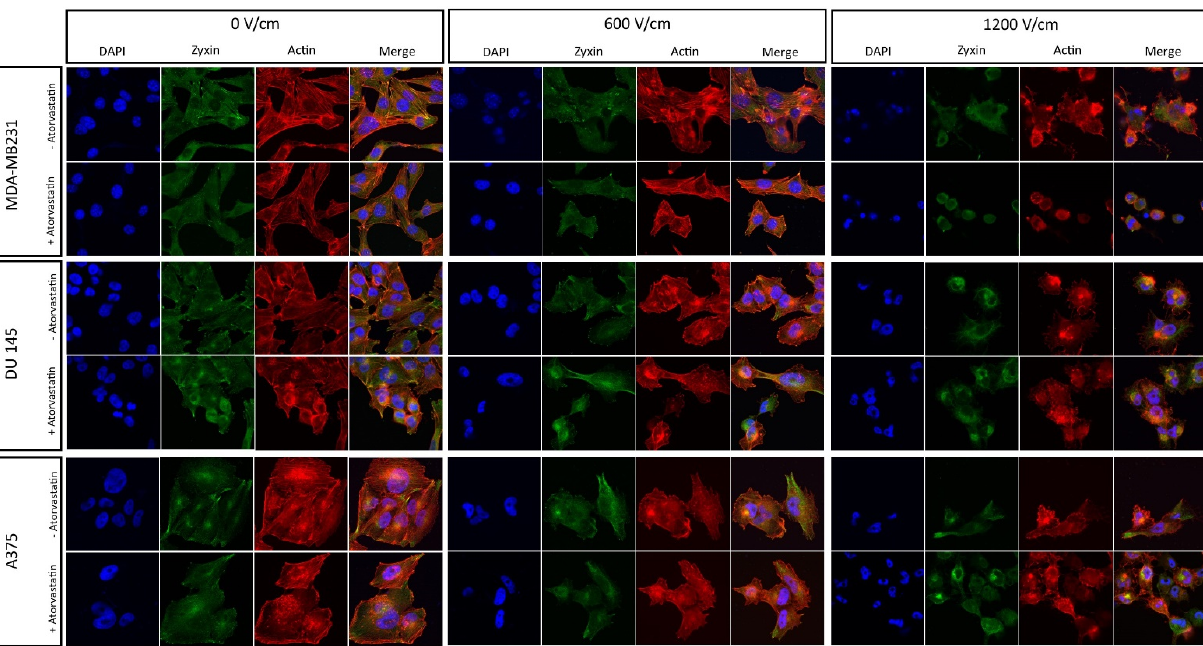
Figure 2. Actin, zyxin, and nuclei organization in MDA-MB231, DU 145, and A375 cells after 48 h incubation with 50 nM atorvastatin followed by electroporation. Six hours after the experiment, the cells were stained and observed on the confocal laser microscope, 60x magnification.